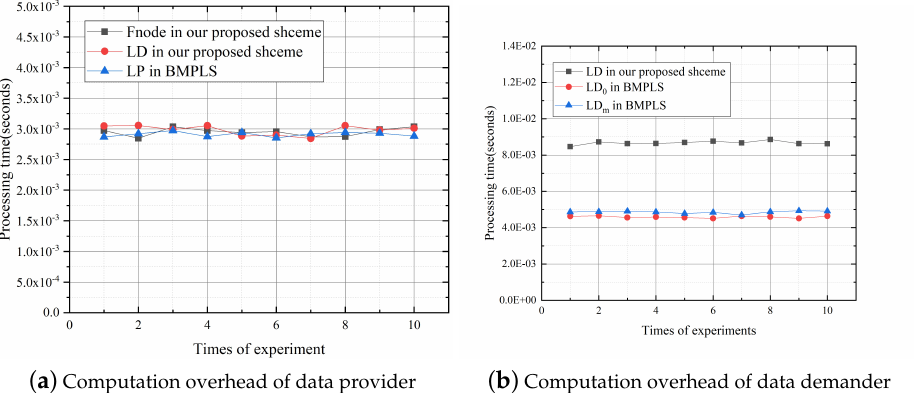
Figure 10. Computation overhead in the location sharing